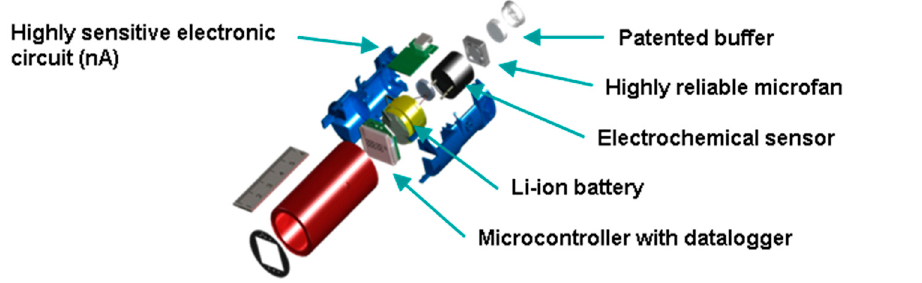
Figure 1. Exploded view of Cairsens NO 2 technology.